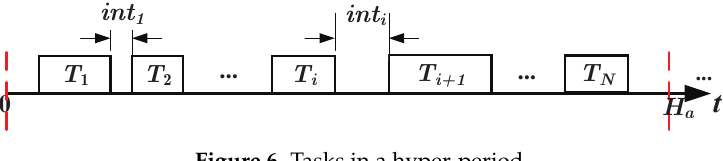
Figure 6. Tasks in a